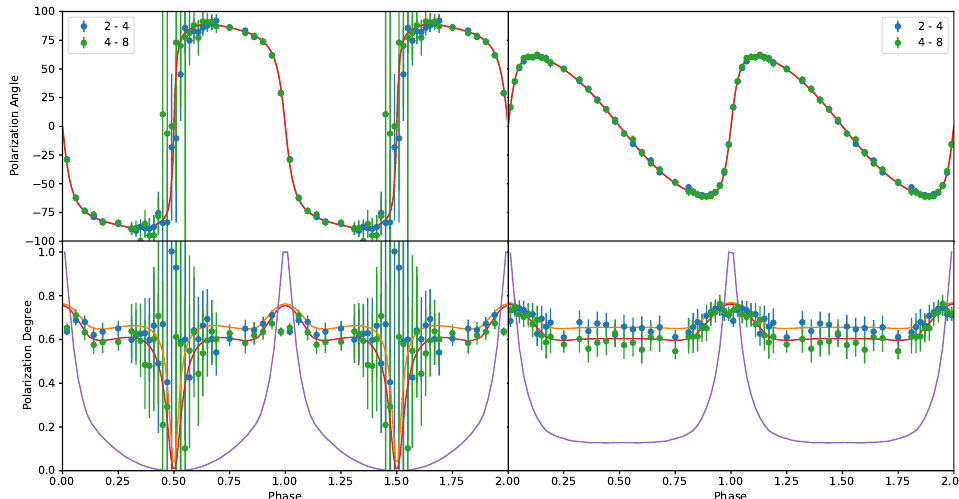
Figure 3. Predicted polarization of Her X-1 from the models of [13] with a 70 ks observation with IXPE. The purple curves in the lower panels depict the total counts from the accretion column in the model. The left panels show the result with a single accretion column and the right panels depict two accretion columns. The large error bars near phase 0.5 in the left panel result from the lack of flux from the accretion column at this phase. The slight discrepancy near phase 1.0 between the measured and model polarization fraction results from smearing the polarization direction over the bin and can be avoided with an unbinned